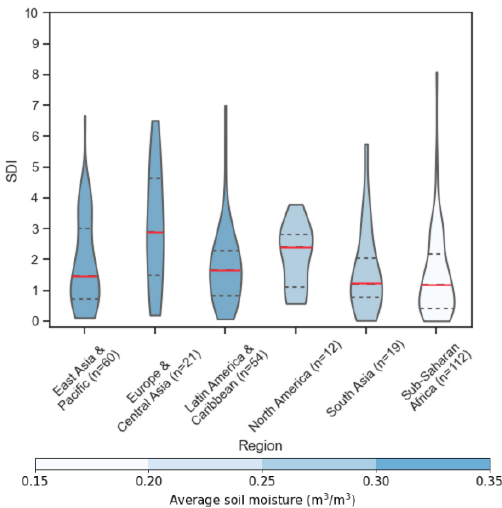
Figure 5. Comparison of the root zone SDI by geographical regions. The red line shows the median value, and grey dotted lines show the 25th and 75th percentile values of each distribution. The colour shows the average soil moisture over the study period